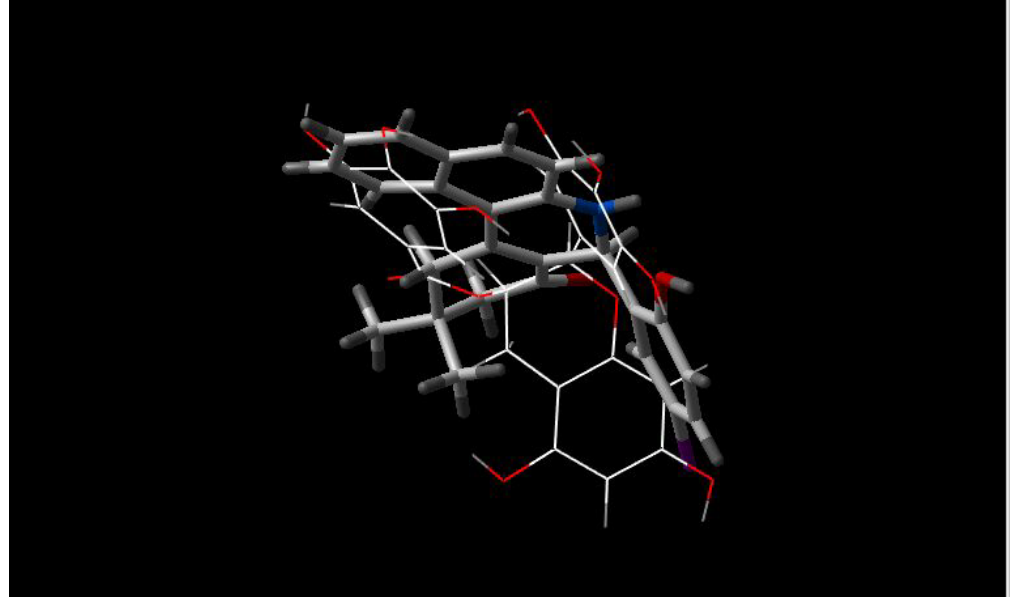
Figure 6. Best fit of optimised INF277 (sticks) and Epigallocatechin-3-O-gallate (wireframe) structures.